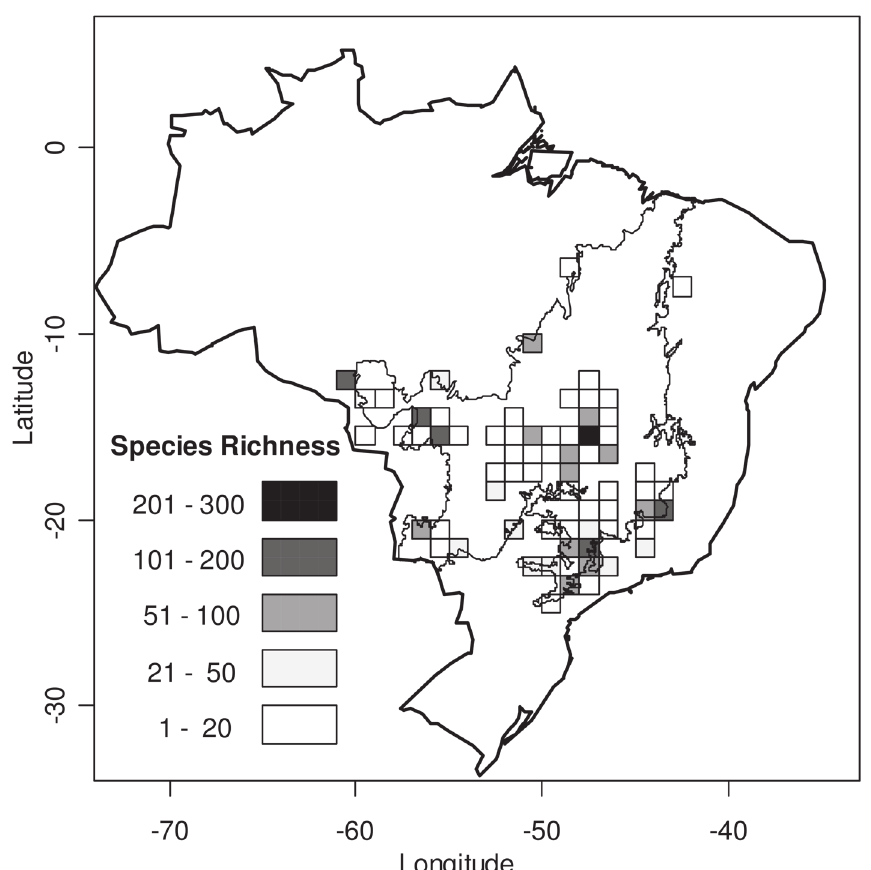
Figure 2. Brazil map including the Cerrado biome polygon and tiger moths richness in one-degree cells. Areas of the Cerrado without cells indicate lack of records. Some cells included areas outside the biome, but records were restricted to localities that could be certainly assigned to the Cerrado